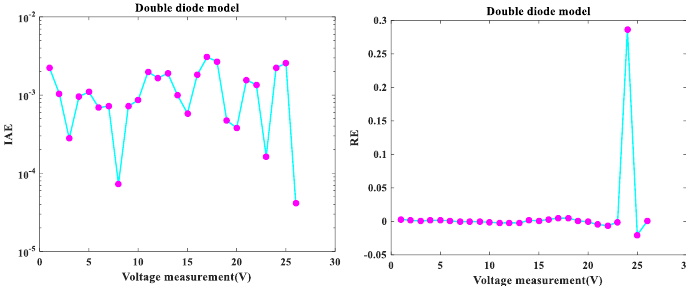
Figure 5. Error index values of DDM IAE values and RE values.